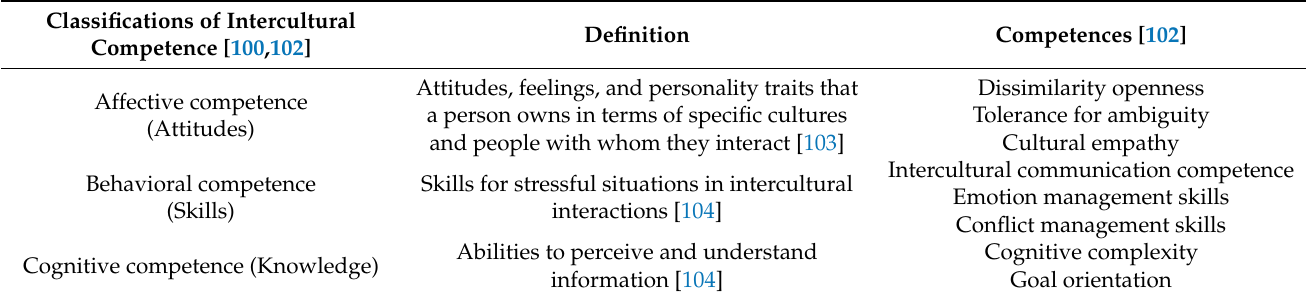
Table 2. Intercultural competence classification